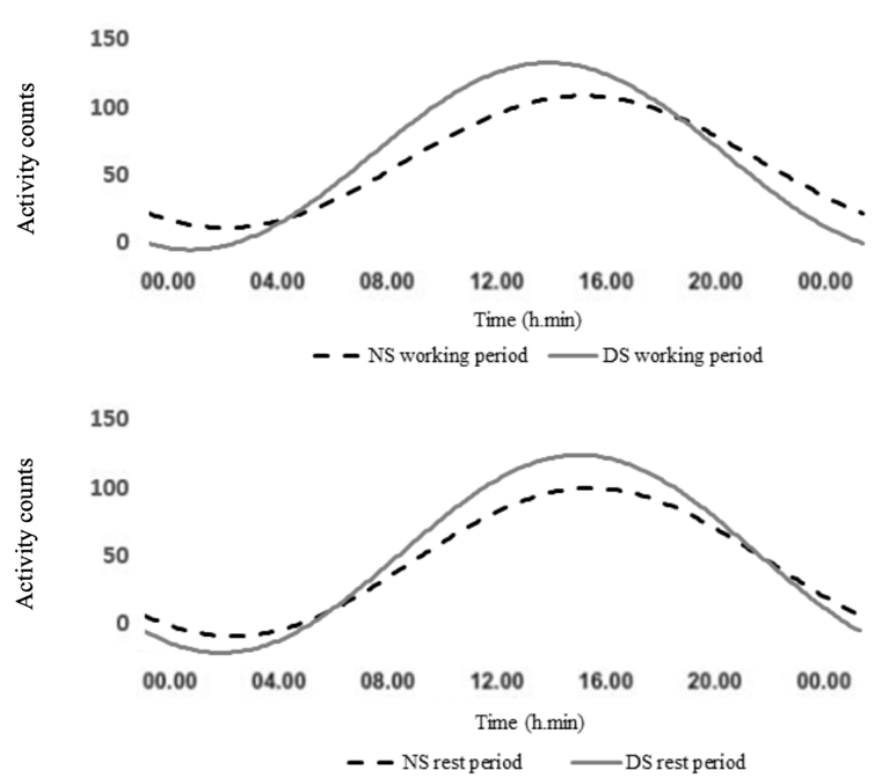
Figure 4. Rest-activity circadian rhythms: data collected by actigraphy in night shift (NS) and day shift nurses (DS) during the working period and the rest period. The dashed black line denotes night shift nurses (NS) for the working and the rest period; the continued grey line denotes day shift nurses (DS) for the working and the rest period.